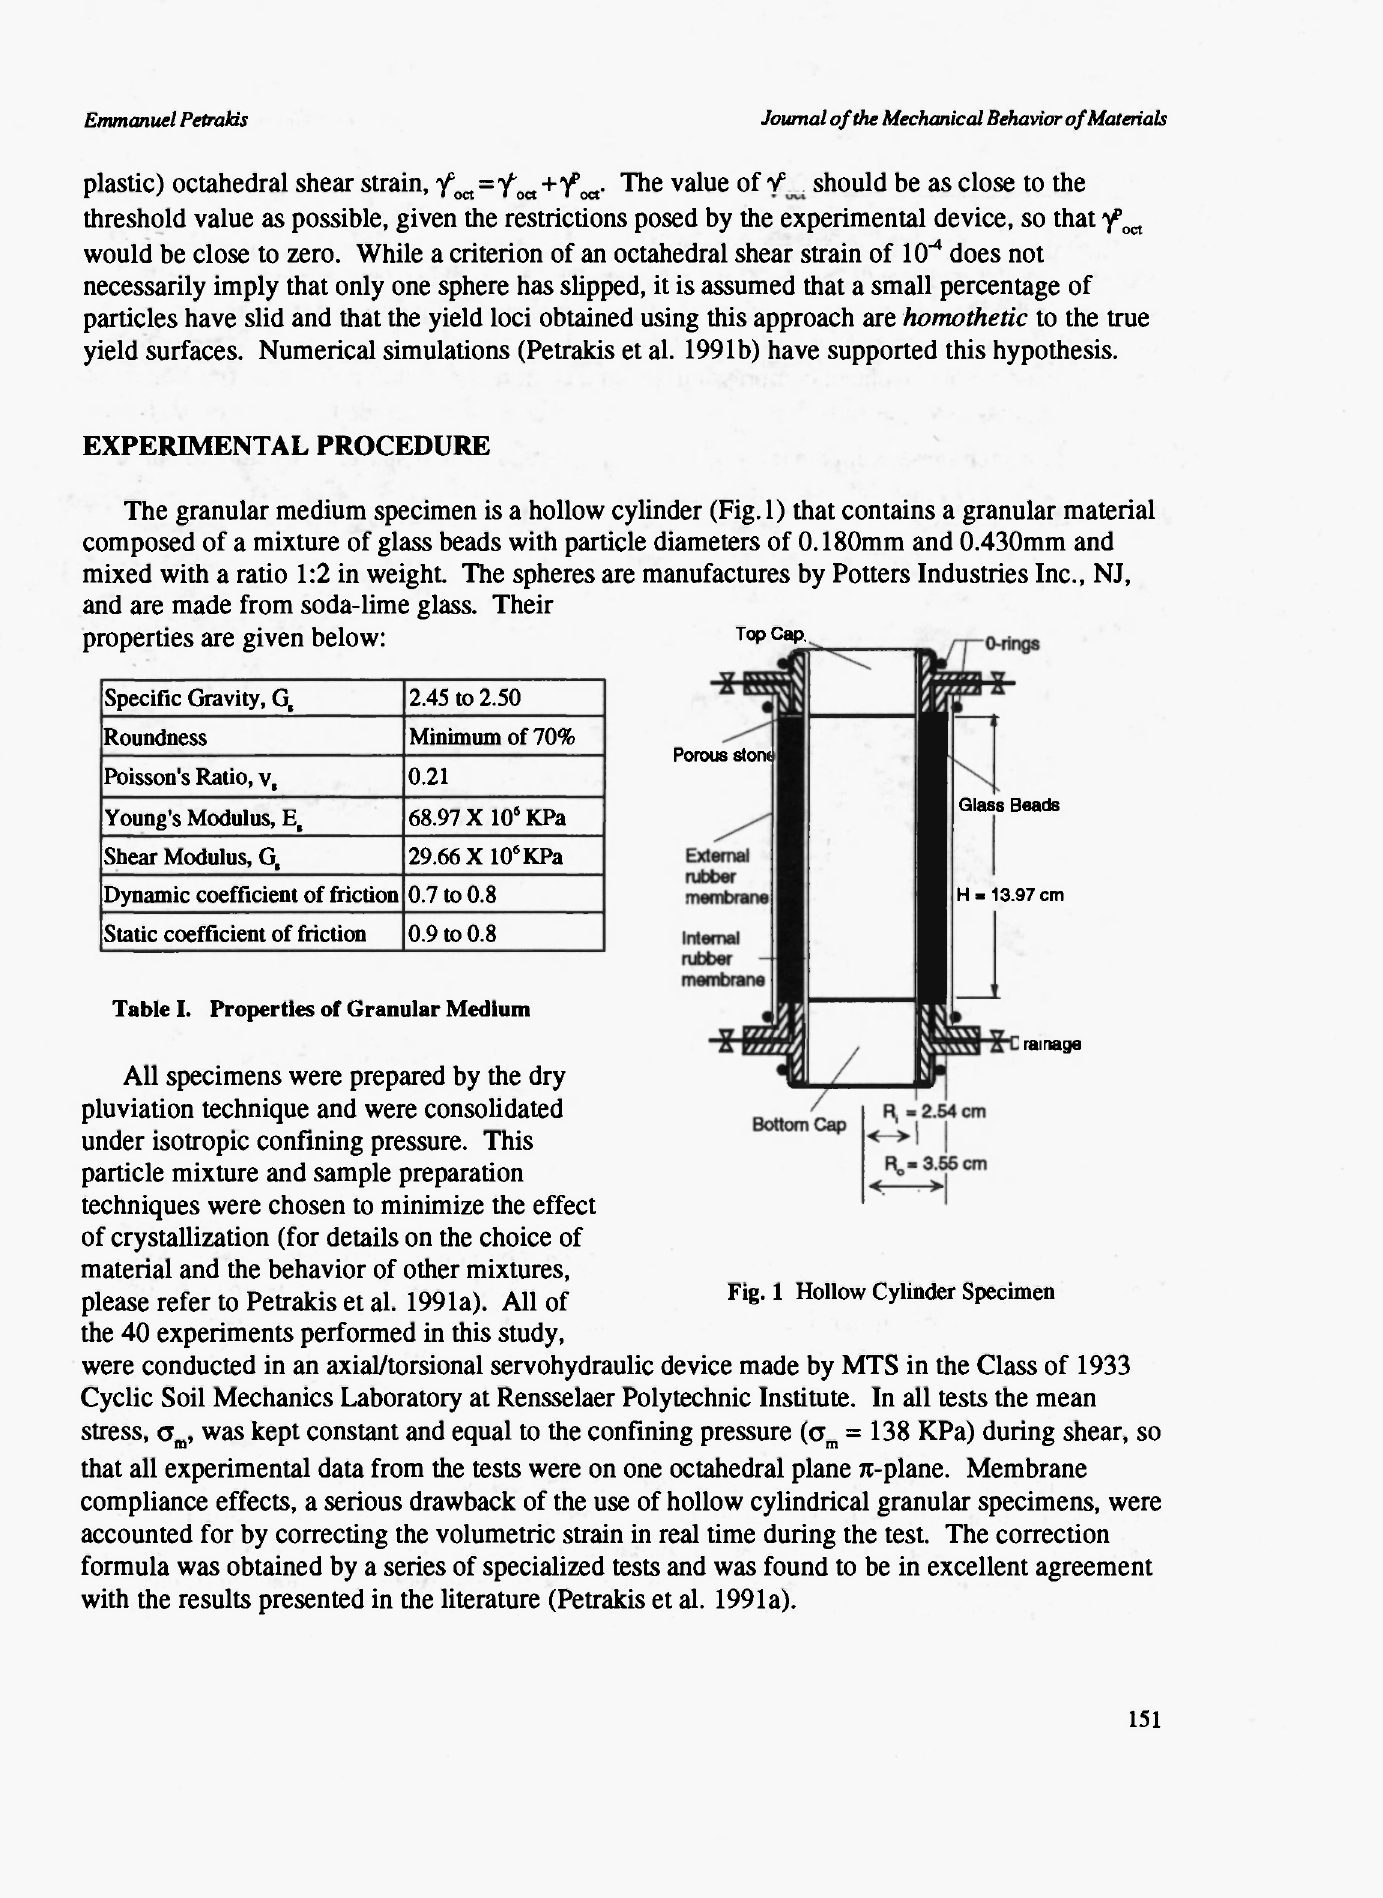
Fig. 1 Hollow Cylinder